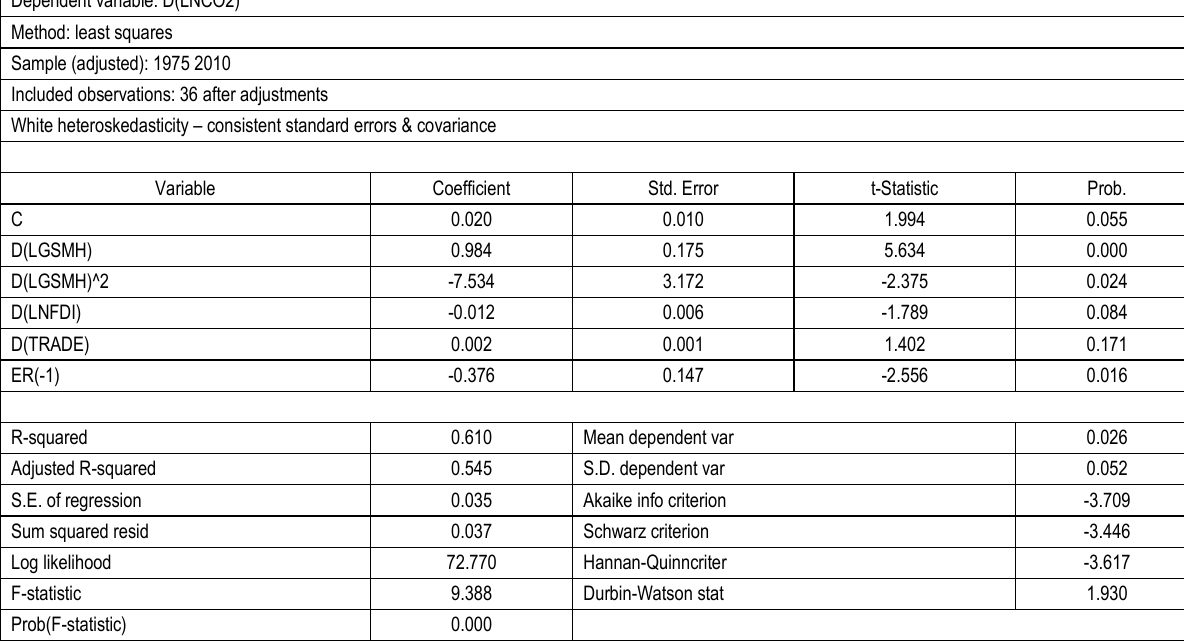
Table 4. Regression test